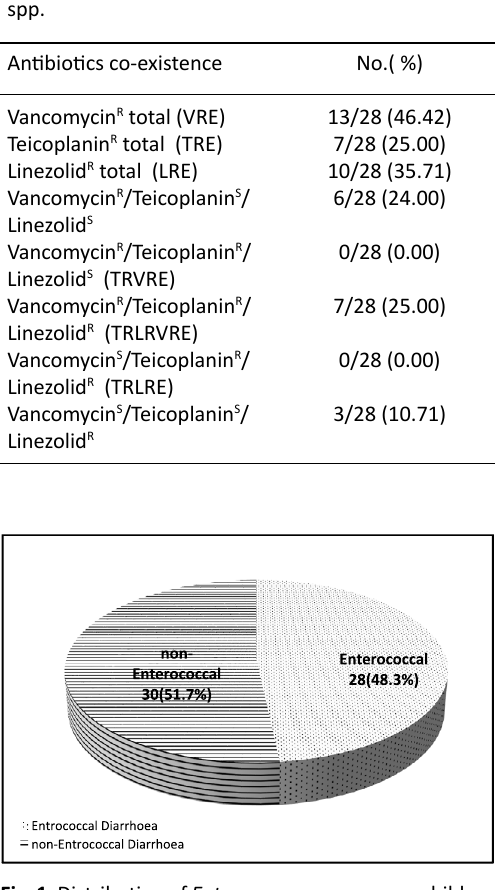
Fig. 1. Distribution of Enterococcus spp. among children